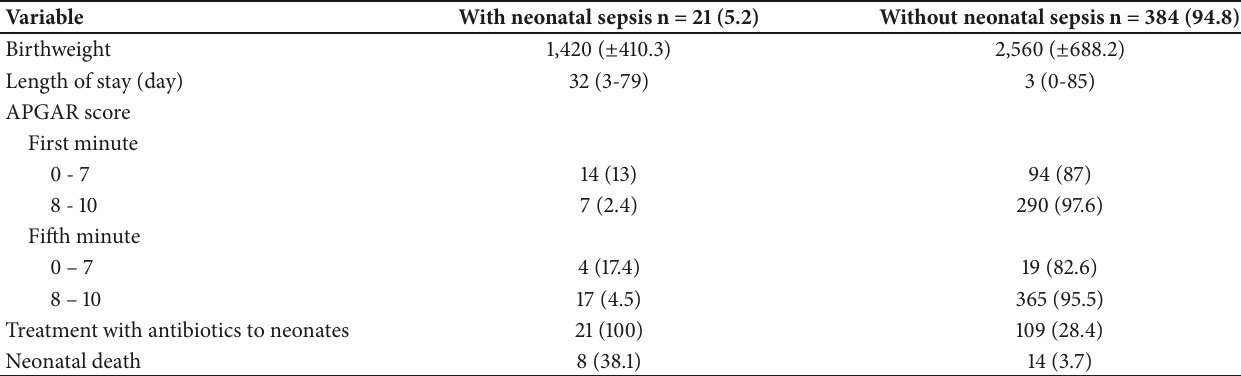
Table 3: Distribution of neonatal outcome in pregnant women with PROM.